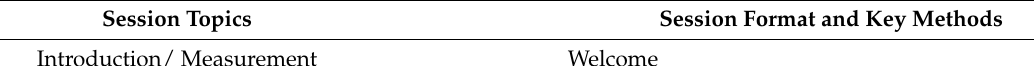
Table 1. Healthy Eagles programme session